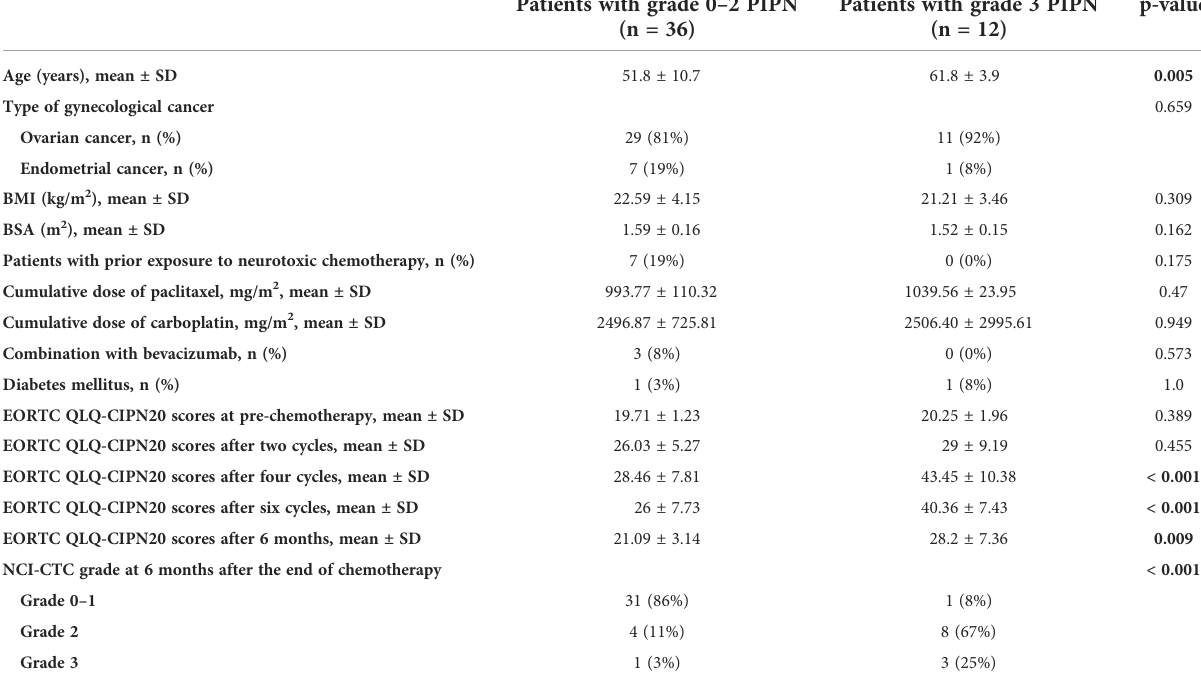
TABLE 1 Comparison of characteristics between grade 3 vs. grade 0 – 2 PIPN patients at the end of